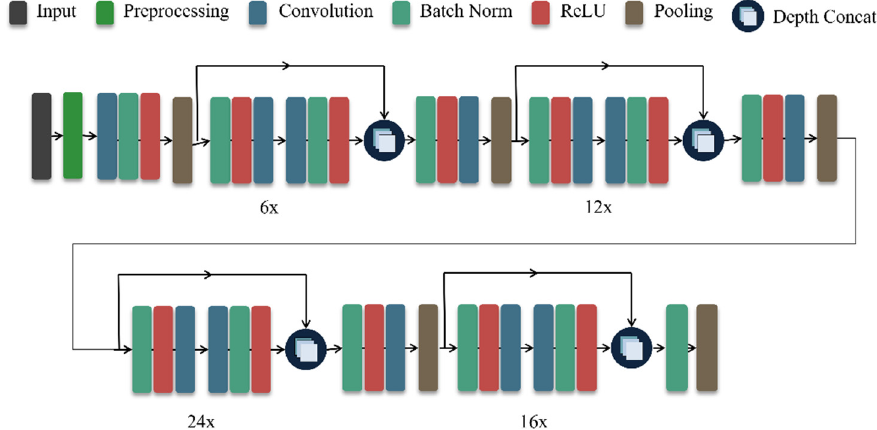
Figure 6. DenseNet architecture.